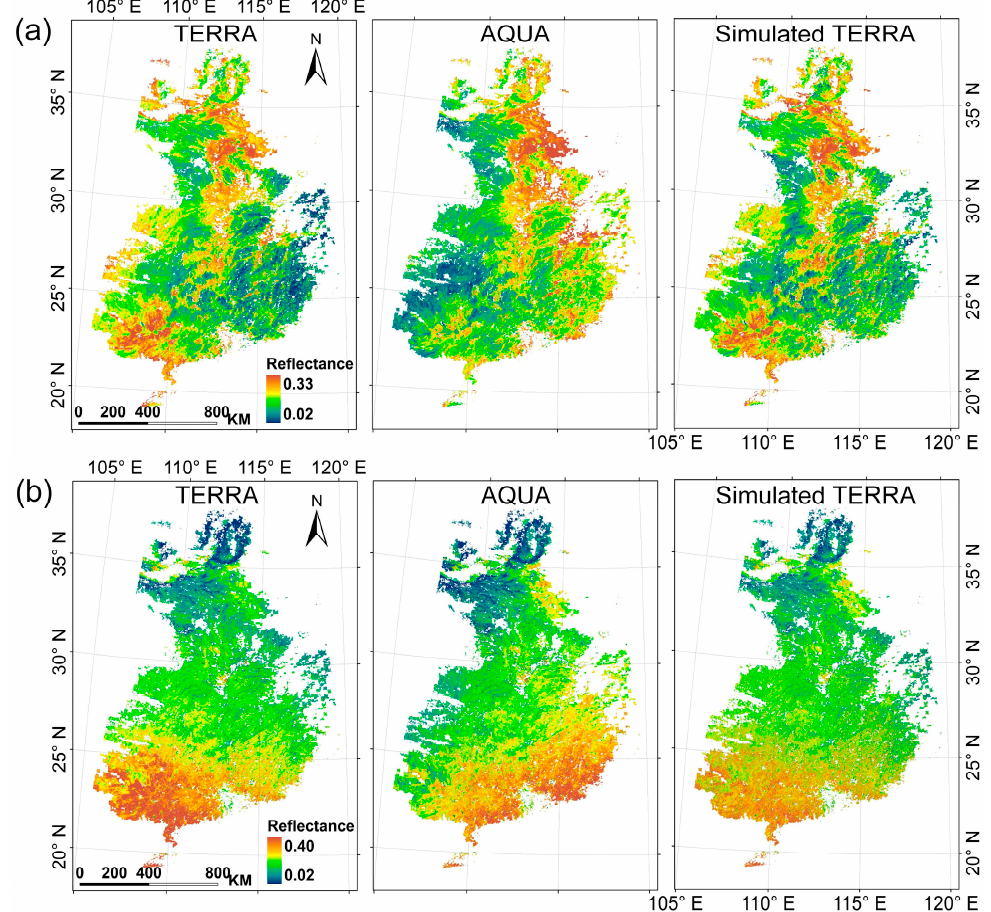
Figure 3. Comparisons of TOA reflectances in ( a ) the red and ( b ) the near-infrared bands. The left frame denotes TERRA MODIS band reflectances, the middle frame denotes the corresponding AQUA MODIS band reflectances, and the right frame denotes the modeled TERRA MODIS band reflectances.